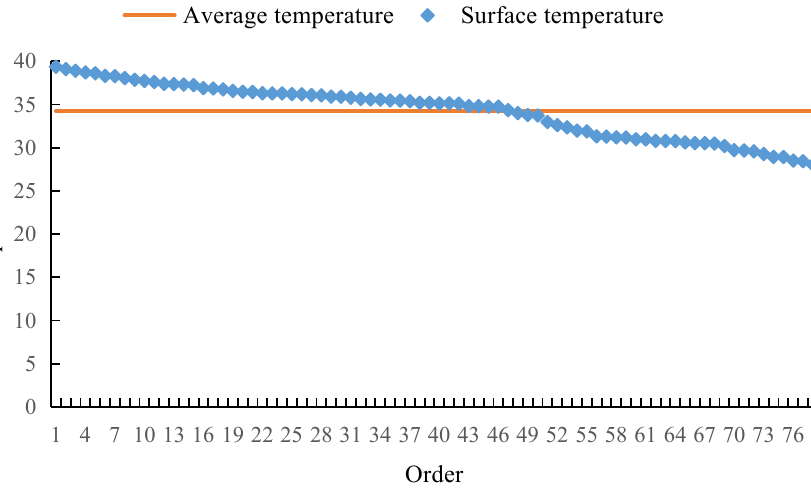
Figure 8. Position order-scale of the surface temperature.